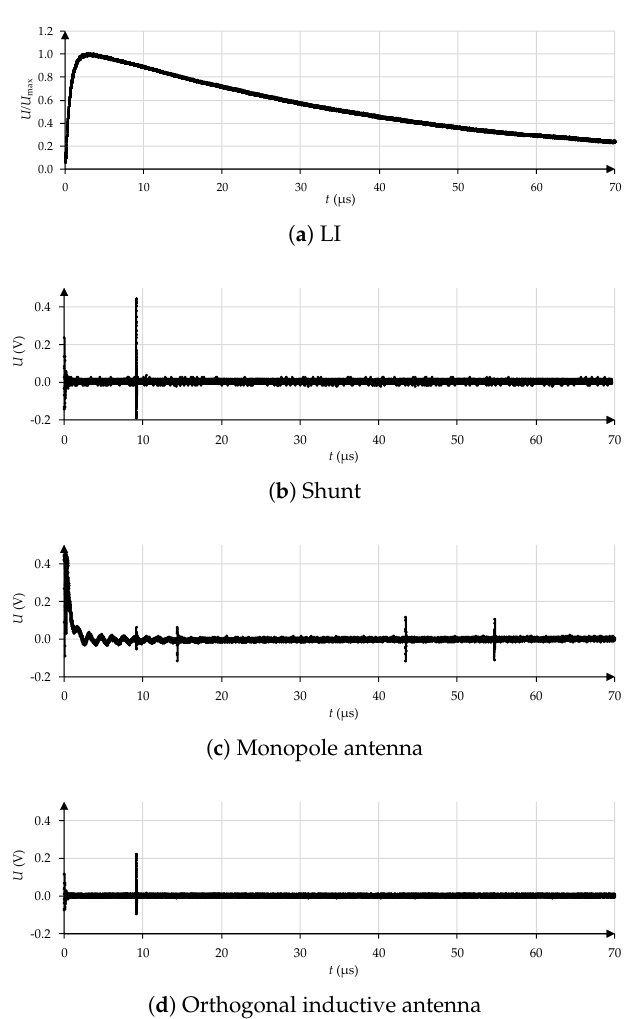
Figure 6. PD detection signals under impulse voltage